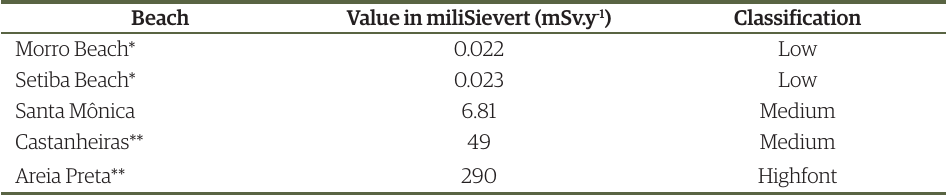
Table 2. Parasites found in samples of positive sands and faeces on the beaches of Santa Mônica, Praia do Morro, Setiba Beach, Castanheiras Beach and Areia Preta Beach.